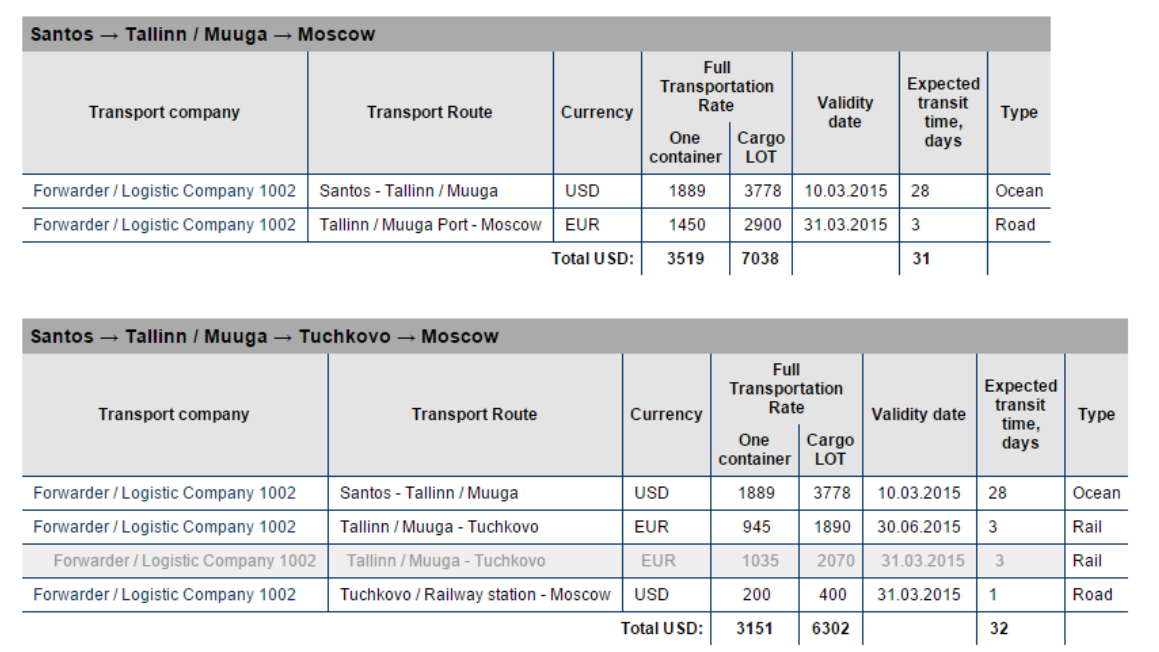
Fig. 8. The results of processing of on-line